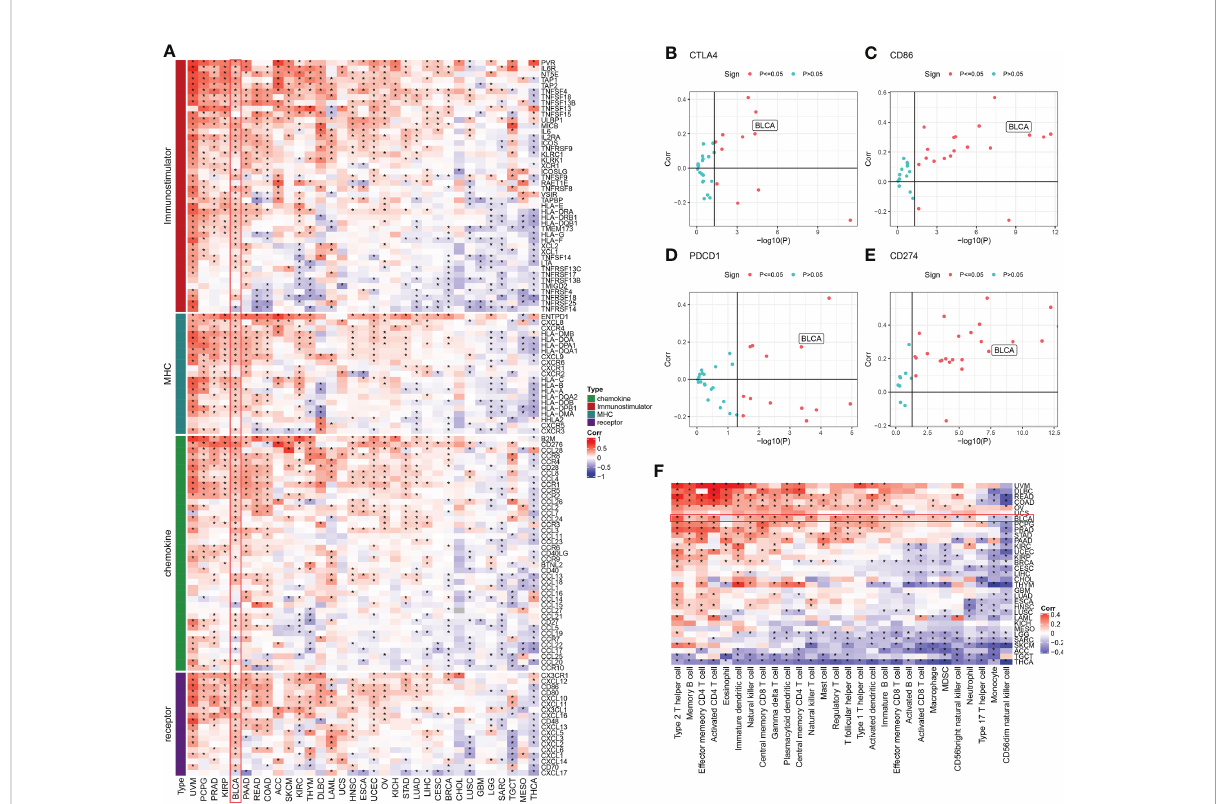
FIGURE 1 Immune correlation analysis of ISCA1 gene in pan-cancer. (A) The link between ISCA1 and immunomodulators (chemokines, receptors, MHC, and immune stimulants). (B – E) The links between ISCA1 and four immune checkpoints (PDCD1, CTLA4, CD274, and LAG3), which represent the type of cancer, was examined. The Y-axis indicated Pearson correlation and the X-axis indicated -log10 (P-value). (F) Spearman correlation analysis was used to measure the link between the expression of the ISCA1 gene in 33 different types of cancer and 28 tumor-related immune cells. The color represents the correlation coef fi cient. An asterisk indicates a statistically signi fi cant P-value calculated using Spearman correlation analysis. (* stands for